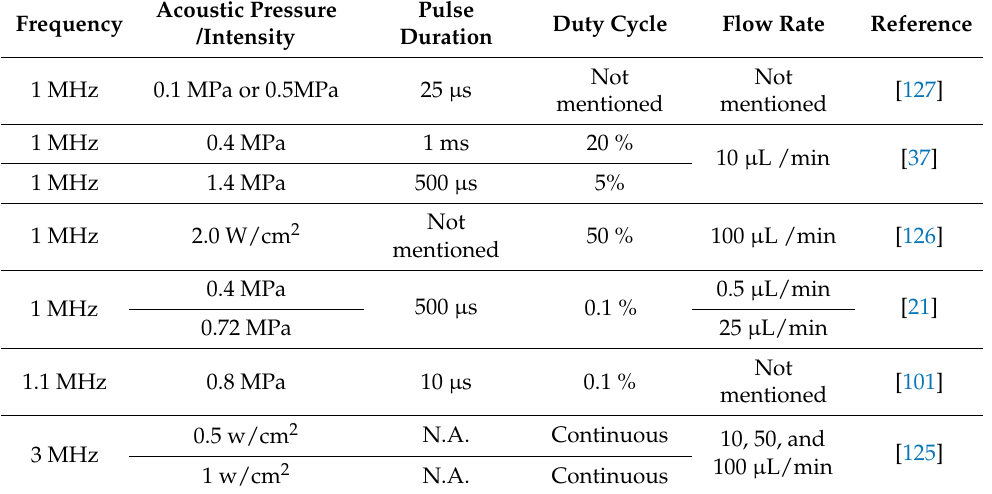
Table 2. A list of the ultrasound parameters used for the disruption of the endothelial barrier by ultrasound-driven microbubbles in recent